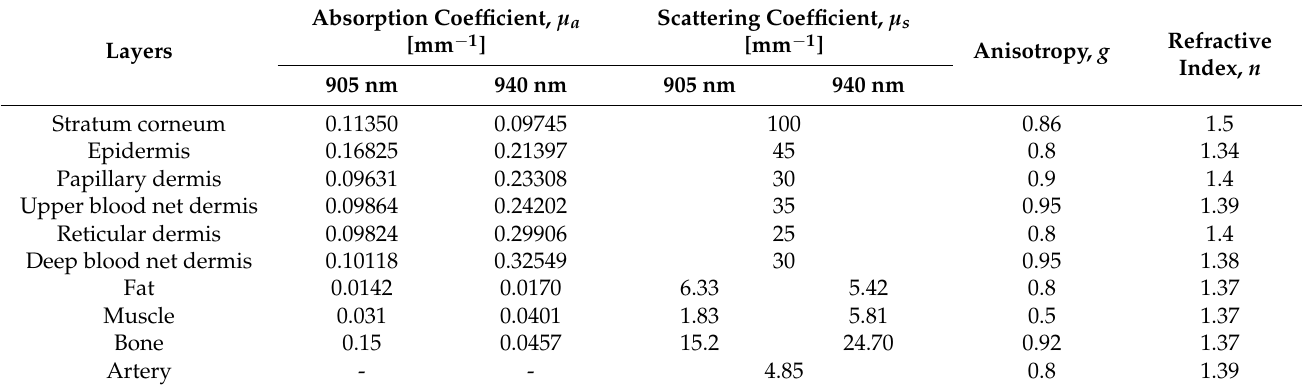
Table 4. Bio-optical properties of the proposed finger